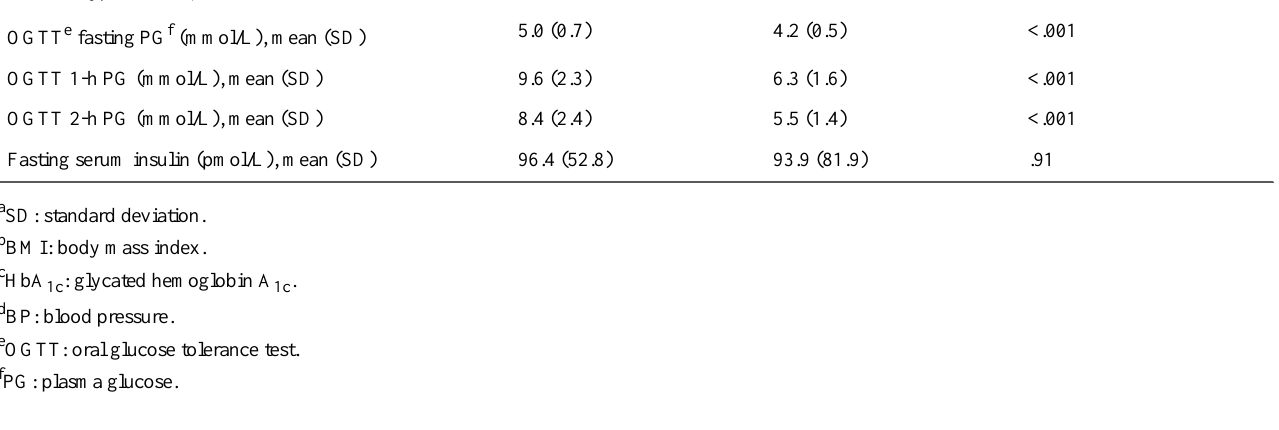
Table 2. Glycemic response and meal characteristics for gestational diabetes mellitus (GDM) and control